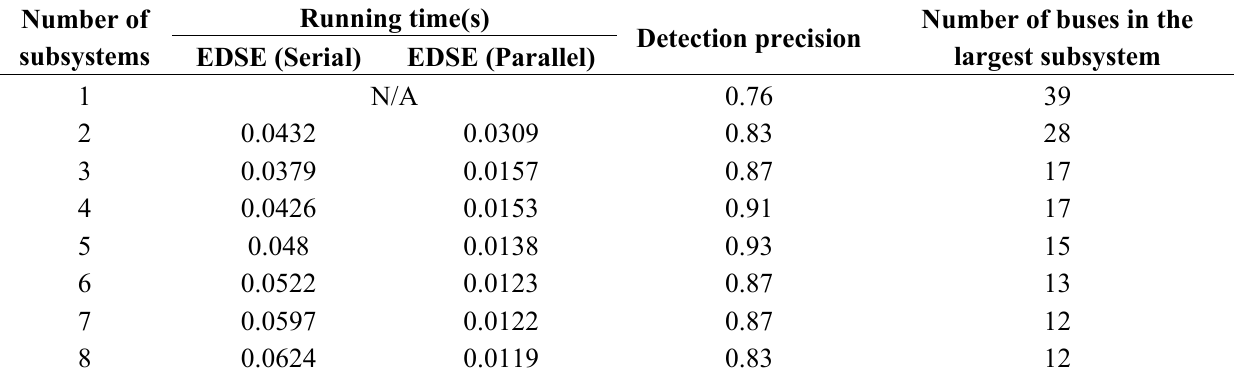
Table 10. Discussion on the number of